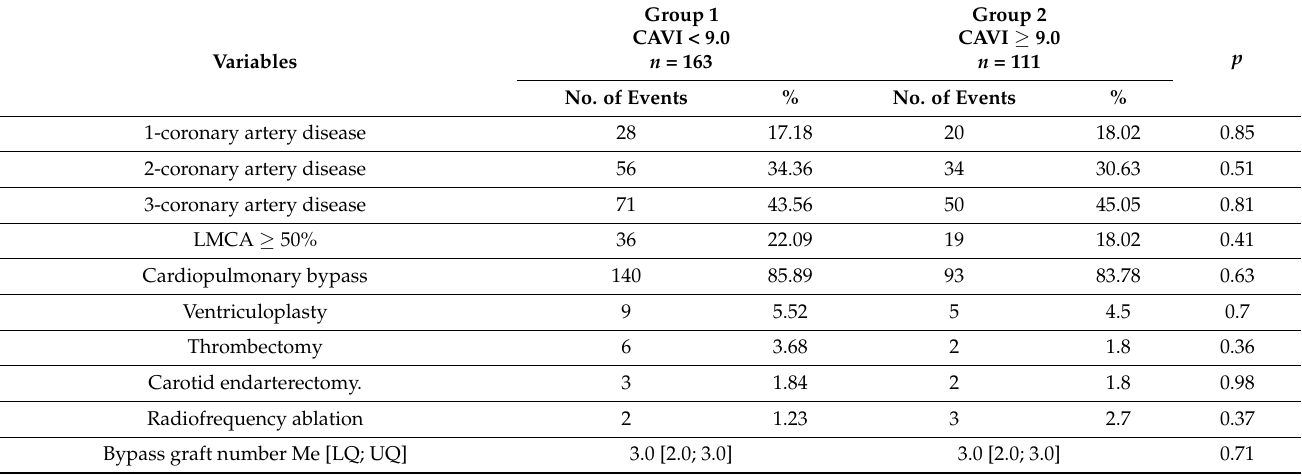
Table 3. Surgical procedure and coronary angiography in groups with pathological and normal